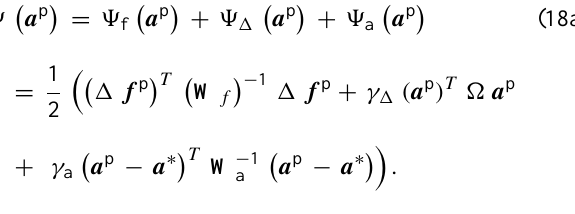
algorithm organization: the general organization of observa- tion fitting and the a priori data